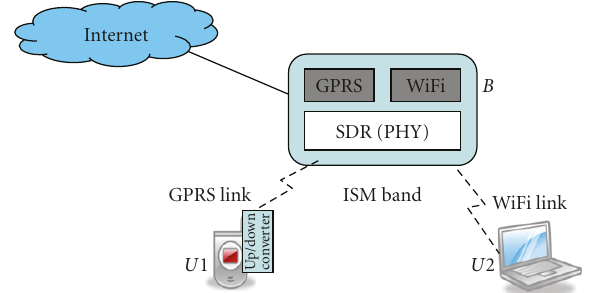
Figure 2: A base station B supports both GPRS and WiFi using frequency converter over the ISM common